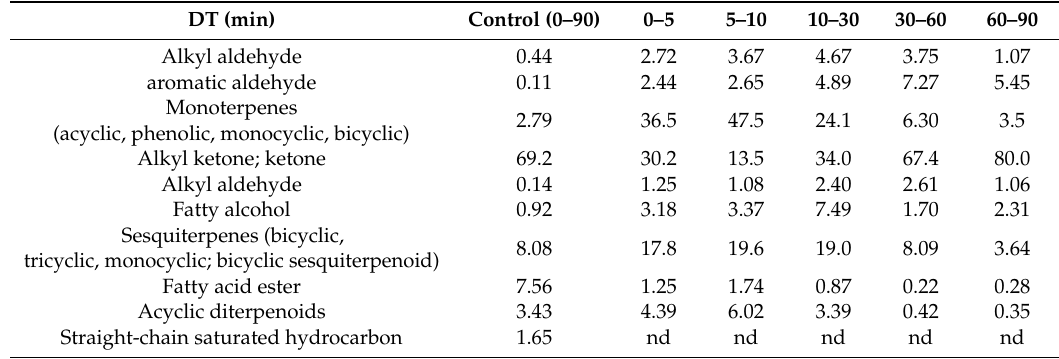
Table 2. Chemical families of Ruta graveolens fruit essential oil (EO) constituents as a function of their extraction during hydrodistillation timeframes (DT).